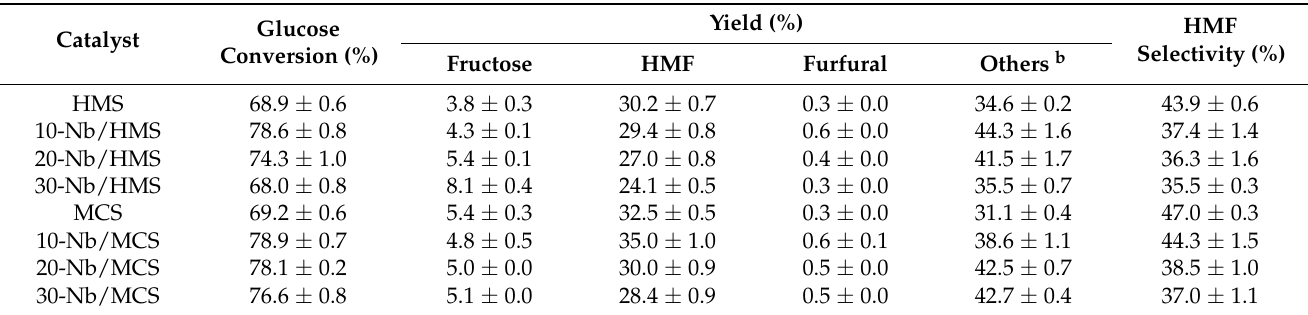
Table 2. Glucose conversion and products distribution obtained from glucose conversion a over the HMS and MCS catalysts with different Nb loading amount.